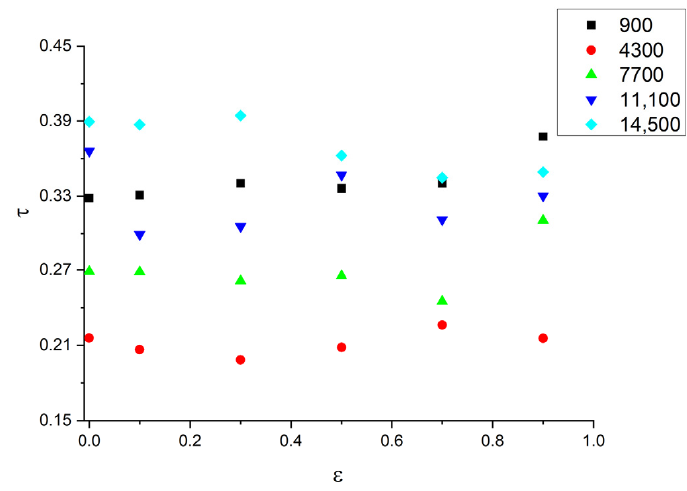
Figure 7. Fluid circumferential average velocity ratio ( τ = v τ / Ω ) of fluid.